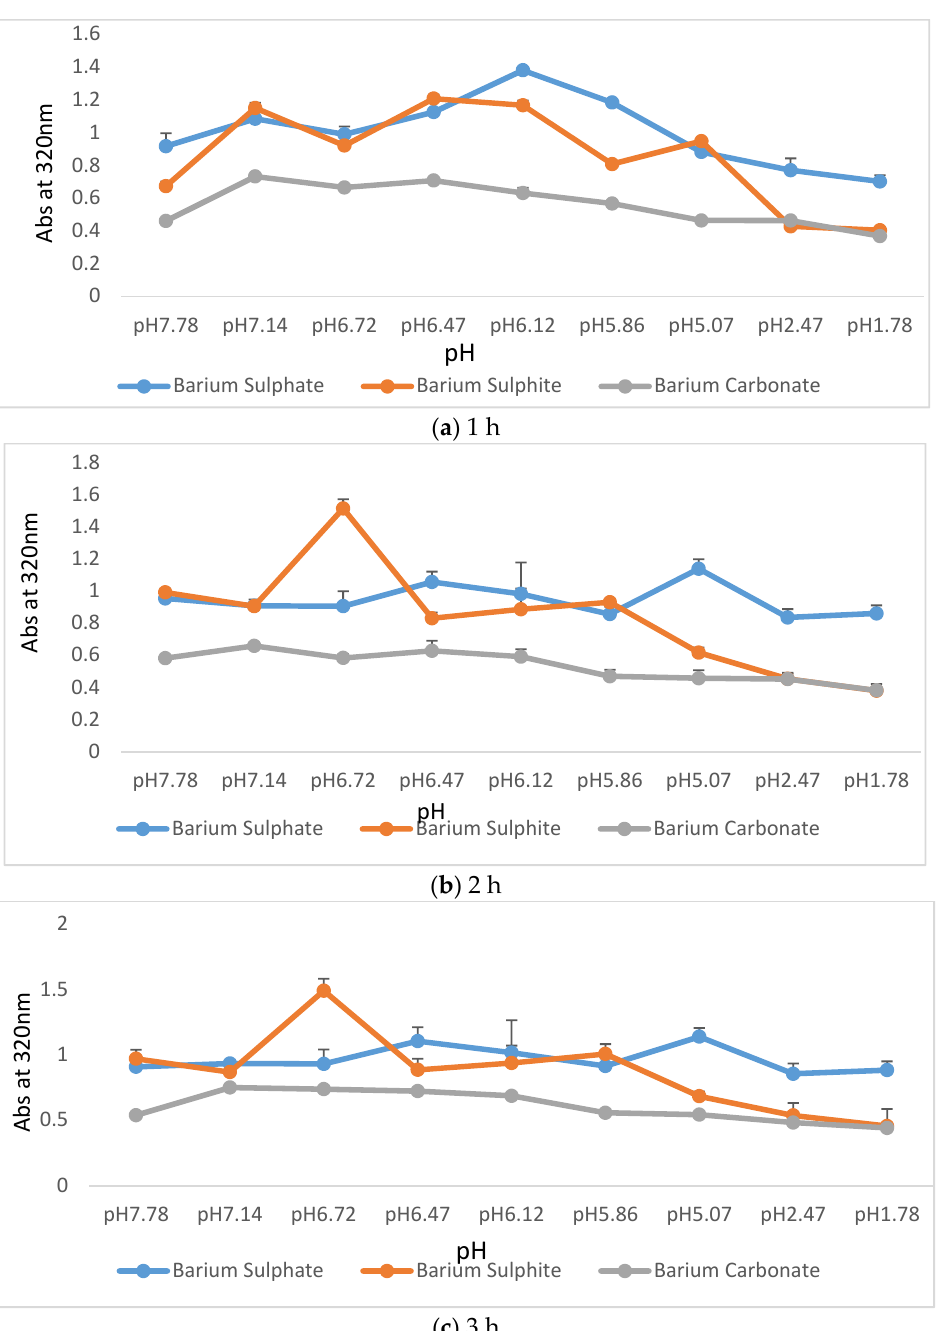
Figure 5. Dissolution of profiles of three different Ba salt particles upon exposure to a wide range of pHs (pH 7.78–pH 1.78) over a time period of 3 h. Ba salt particles were synthesized at pH 7.78 and exposed to different pHs to observe particle dissolution. ( a ), ( b ) and ( c ) plots data from 1 h, 2 h and 3 h respectively.